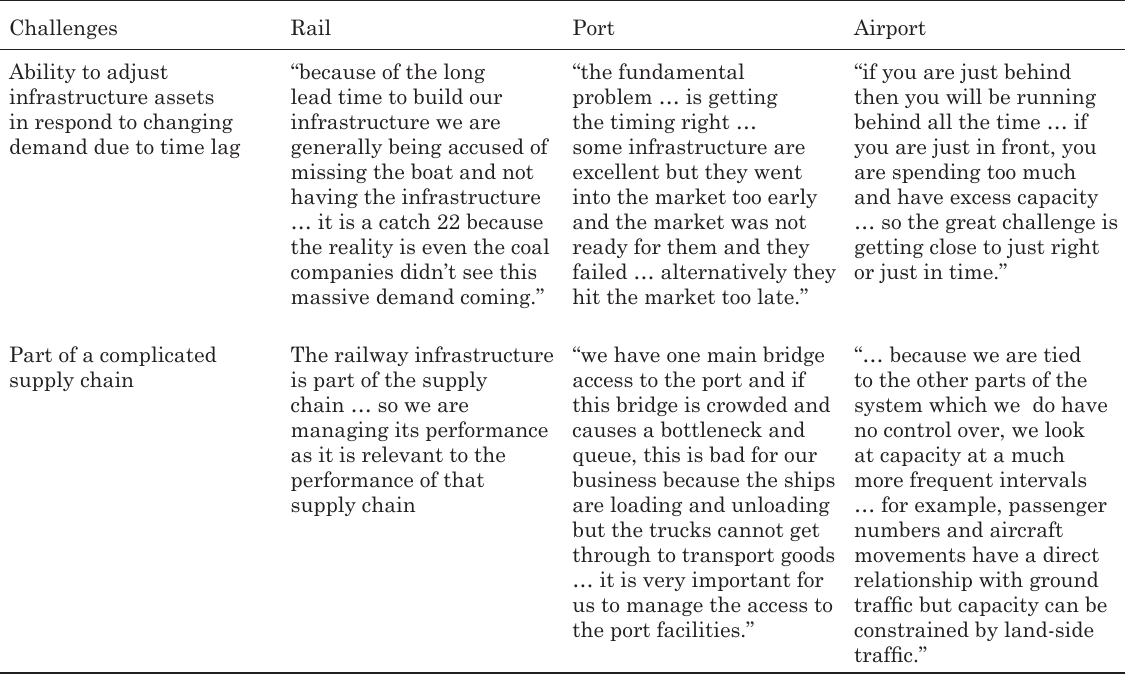
table 3. Summary of challenges in the capacity management process